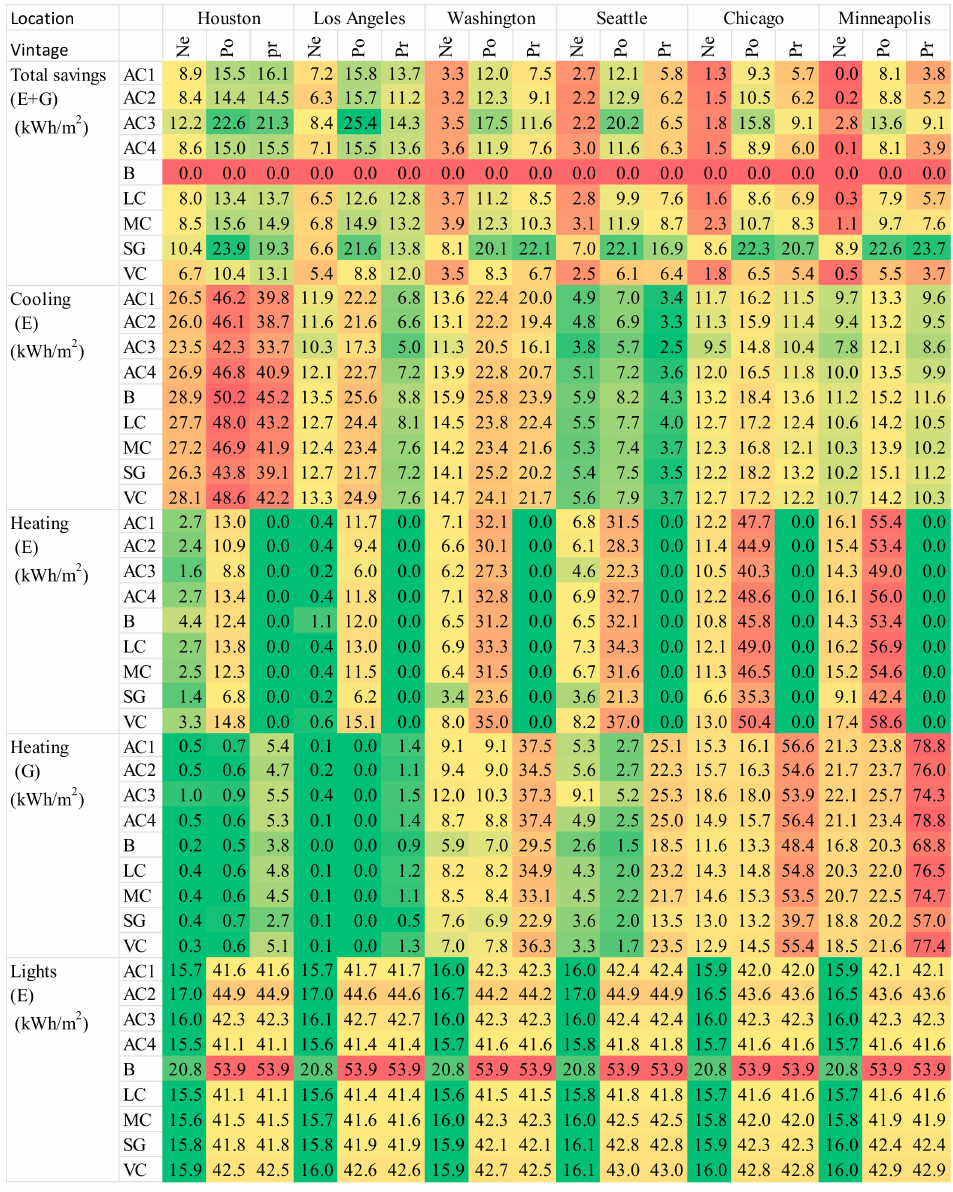
Figure 3. Energy consumption and savings for di ff erent shade control strategies at six di ff erent locations and three di ff erent building vintages: Ne–New2016; Po–Post1980; Pr–Pr1980 vintage; E–Electricity; G–Gas. (For the Total Savings color diverges from green to red from higher value to lower value while for all other color diverges from red to green from higher value to lower